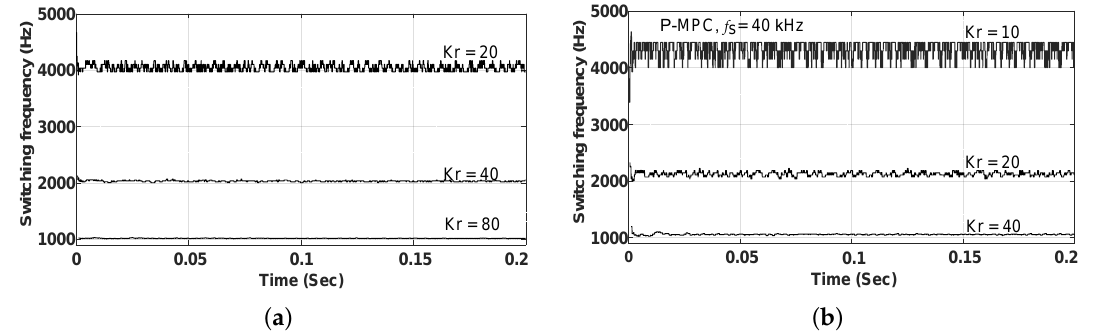
Figure 16. The effectiveness of periodic control at different reference frequencies using two sampling values. ( a ) 80 kHz sampling; and ( b ) 40 kHz sampling. ( a ) The switching frequency measurements for different references K r ; ( b ) The switching frequency measurements for different references K r